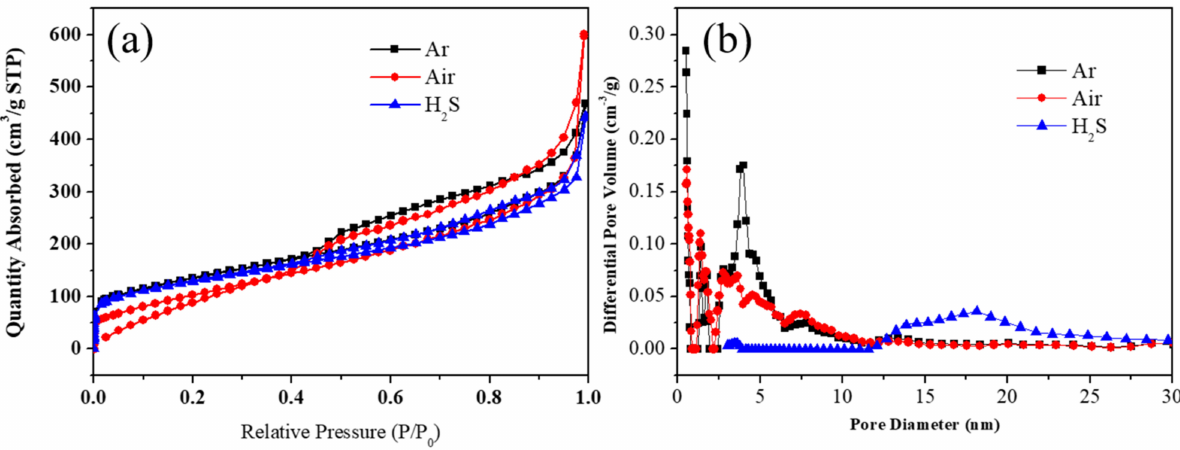
Figure 9. The ( a ) N 2 sorption isotherm plots and ( b ) pore size distribution curves of multi-doped porous carbon nanofibers derived from different Ni 1 Co 4 -ZIFs/PAN nanofibers by carbonization, oxidation, and sulfurization in different atmospheres (Ar, Air, and H 2 S) at 800 ◦ C. The ORR and OER performances under different carbonization states were